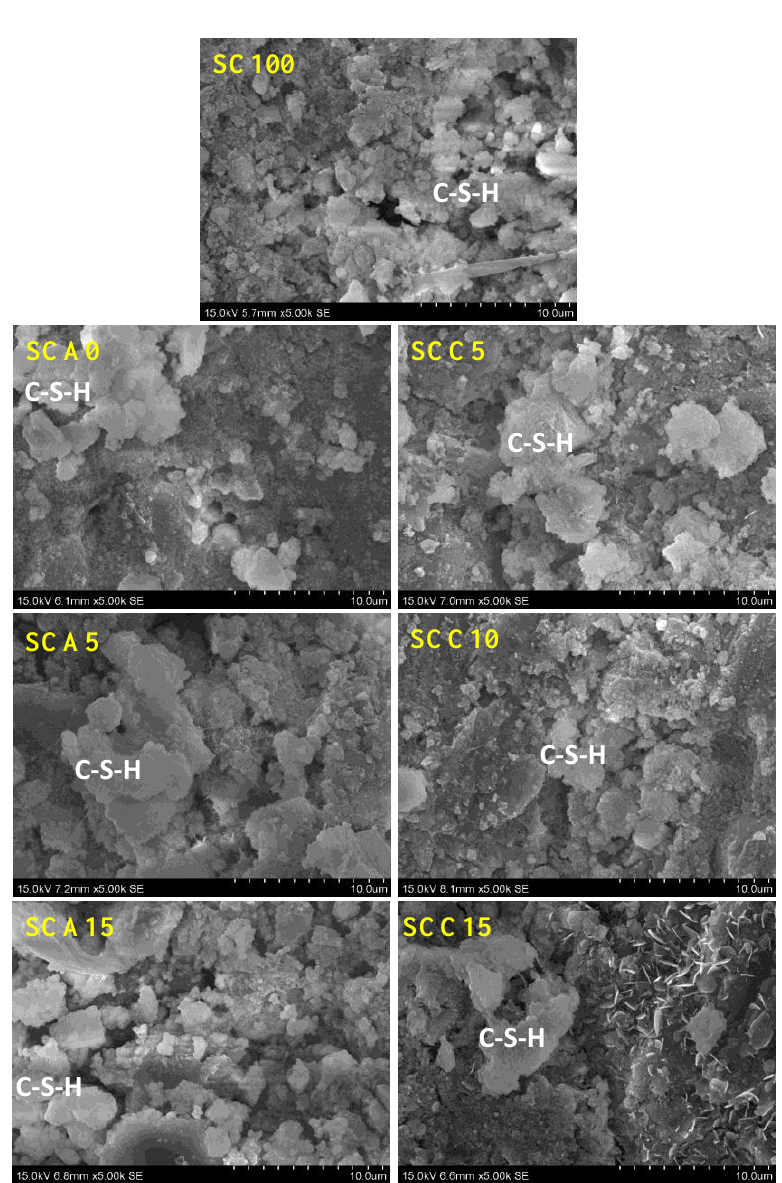
Figure 13. SEM observation of binder pastes after 28 days of hydration (Mag = 5000×).